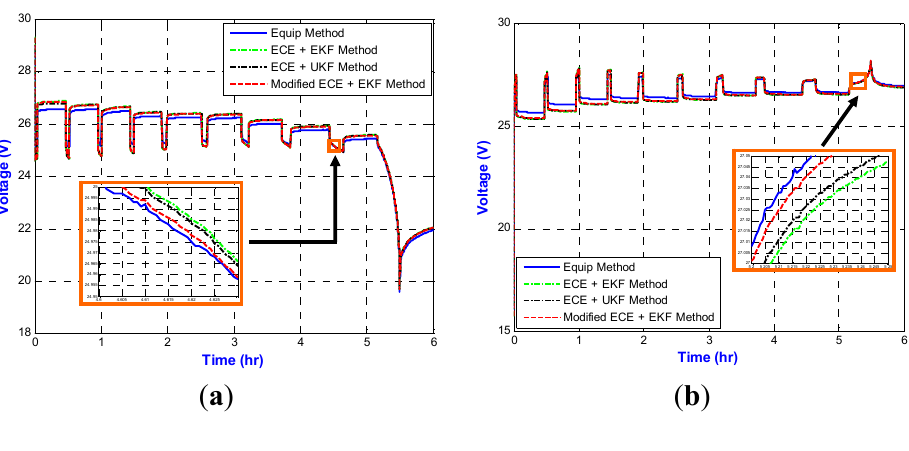
Figure 11. Modeling results in Experiment II. ( a ) Discharge; ( b )